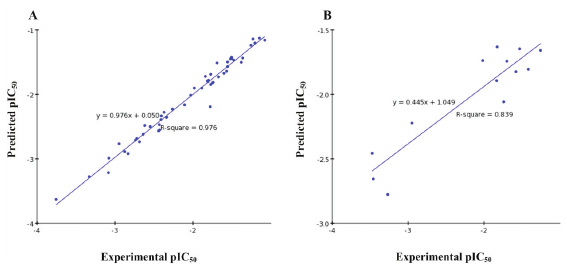
values; (A) training 50